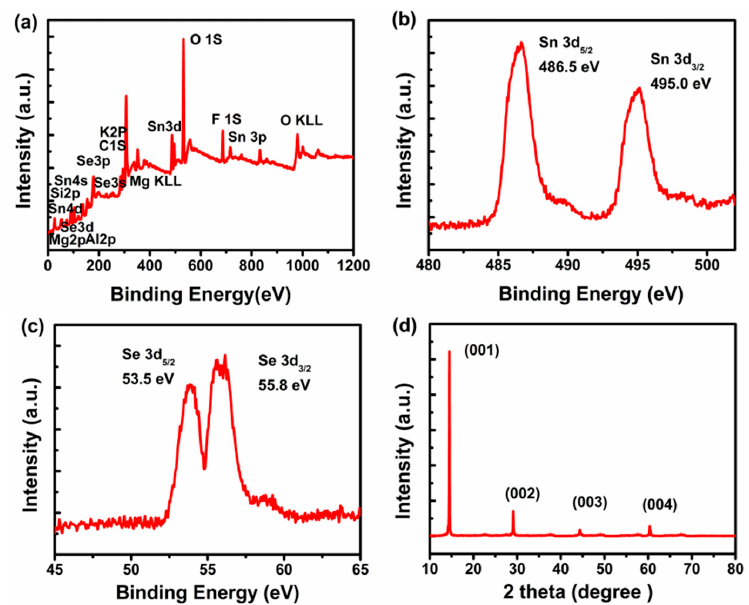
Figure 3. X-ray photoelectron spectroscopy (XPS) and X-ray diffraction (XRD) characterization of the SnSe 2 crystal on mica. ( a ) The whole range of an XPS spectrum of the SnSe 2 ; ( b , c ) XPS peak of Sn and Se elements in the SnSe 2 crystal, respectively; ( d ) XRD pattern of the SnSe 2 crystal. XRD patterns were characterized to elucidate the overall crystallinity on a mica substrate. The XRD pattern obtained from SnSe 2 nanoflakes is shown in Figure 3d. The XRD pattern of as-synthesized crystal is very consistent with the characteristic peaks of standard SnSe 2 . The prominent peaks at 2 θ values of 14 ◦ , 29 ◦ , 44.2 ◦ , and 60 ◦ , correspond to the (001), (002), (003), and (004) planes of SnSe 2 , respectively [29,31,41]. This shows that the SnSe 2 has a hexagonal lattice structure. The most obvious peak is located at 2 θ = 14 ◦ , corresponding to the (001) crystal plane, revealing that the SnSe 2 crystal grain preferentially grows along the c -axis. In addition, the obtained nanoflakes have a